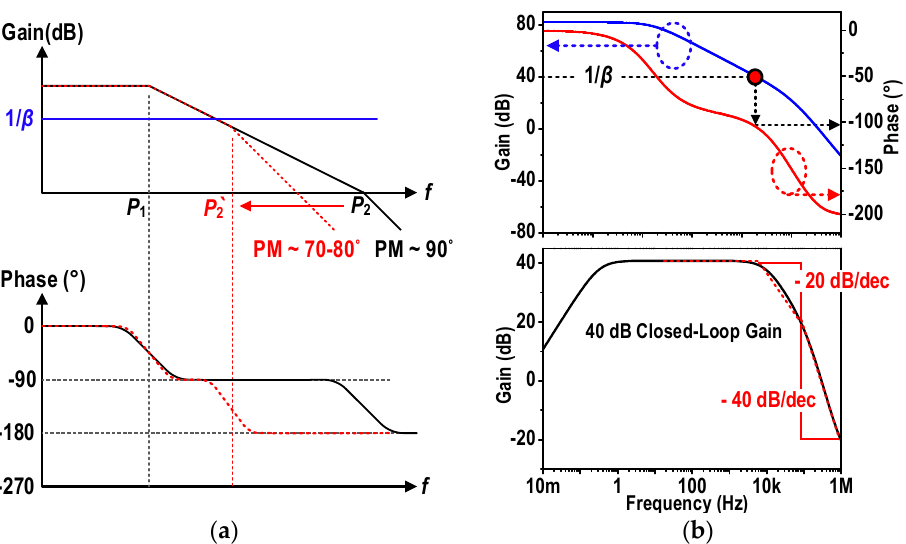
Figure 8. Early introduction of 2 nd pole in the LNA: ( a ) Conceptual Bode diagrams for the conven- tional case where P 2 >> P 1 and the proposed case where P ’ 2 is intentionally introduced in lower frequency; ( b ) Simulated Bode diagram of the OTA in Figure 3b with the early introduction of the 2 nd pole (top), and the closed loop gain response (bottom).